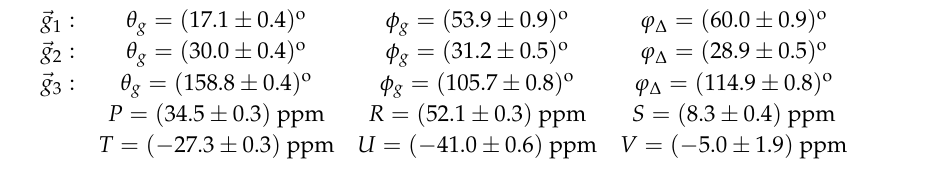
Figure 3. (a) Single crystal of aluminum nitride, AlN, from Leibniz Institute for Crystal Growth (IKZ, Berlin), with the crystallographic c axis and ab plane indicated by arrows.[10] (b) Wurtzite structure of AlN, according to Reference [9], viewed down the crystallographic (11-20) direction. The aluminum atoms (grey) and the nitrogen atoms (yellow), both located at Wyckoff position 2 b , are tetrahedrally coordinated by each other with one Al-N bond directed parallel to the crystallographic c axis. (c) Individual, tetrahedrally coordinated, aluminum and nitrogen atom in the crystal structure of AlN, in which the three equal, shorter, bonds Al/N—I/II/III [1.8891(8) Å] and the longer bond Al/N—IV [1.9029(16) Å] along the three-fold rotation axis are highlighted. a Drawing generated with the Vesta program [11].